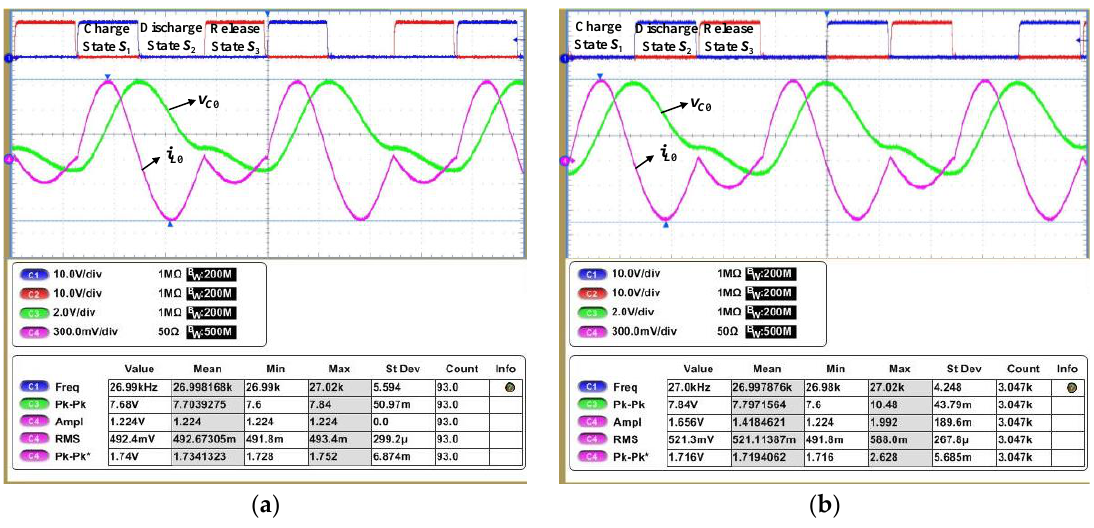
Figure 15. Experimental waveforms of the proposed equalizer with different switching sequences. ( a ) energy transfer from B 0 to B 1 ; ( b ) energy transfer from B 1 to B 0 .